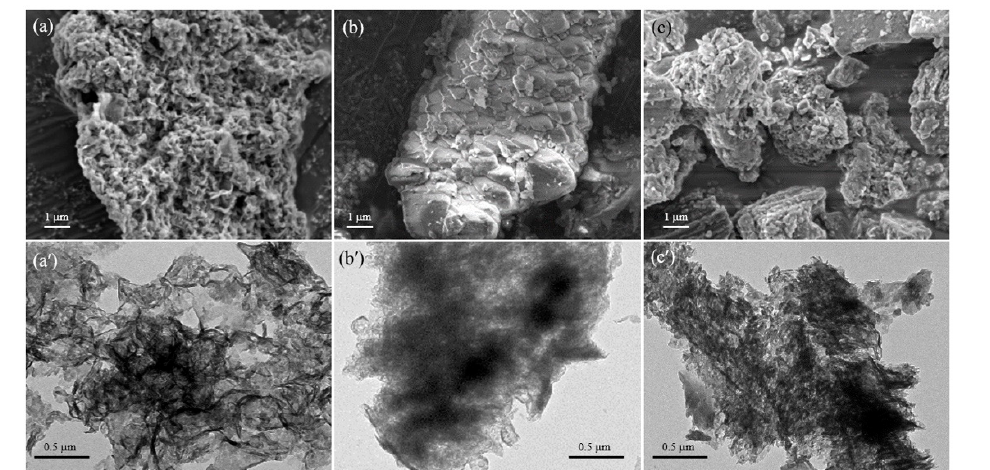
Figure 1. XRD patterns of: ( a ) gCN; and ( b ) Ti-uCN.